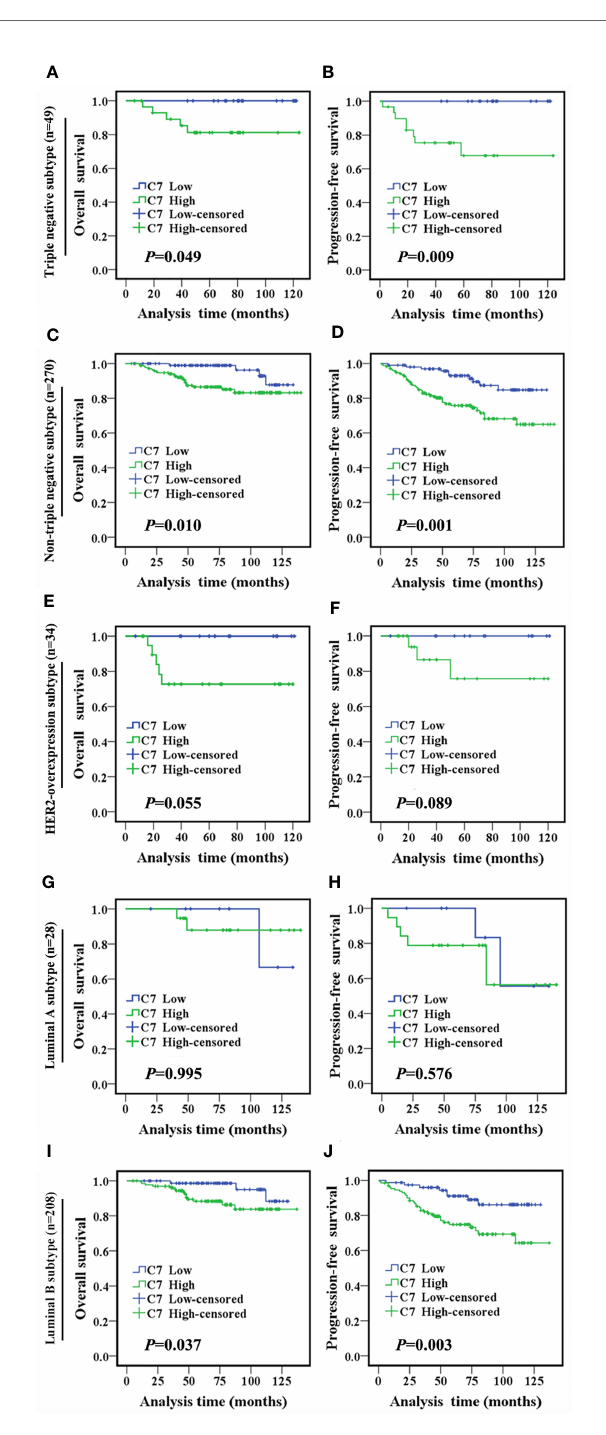
FIGURE 2 | High expression of C7 indicated a shorter survival in IDC patients, especially in the triple negative subtype and luminal B subtype. (A, B) OS and PFS curves of patients with triple negative subtype (n = 49). (C, D) OS and PFS curves of patients with the non-triple negative subtype (n = 270). (E, F) OS and PFS curves of patients with the HER2-overexpression subtype (n = 34). (G, H) OS and PFS curves of patients with the luminal A subtype (n=28). (I, J) OS and PFS curves of patients with the luminal B subtype (n=208). [ (A – J) : log-rank